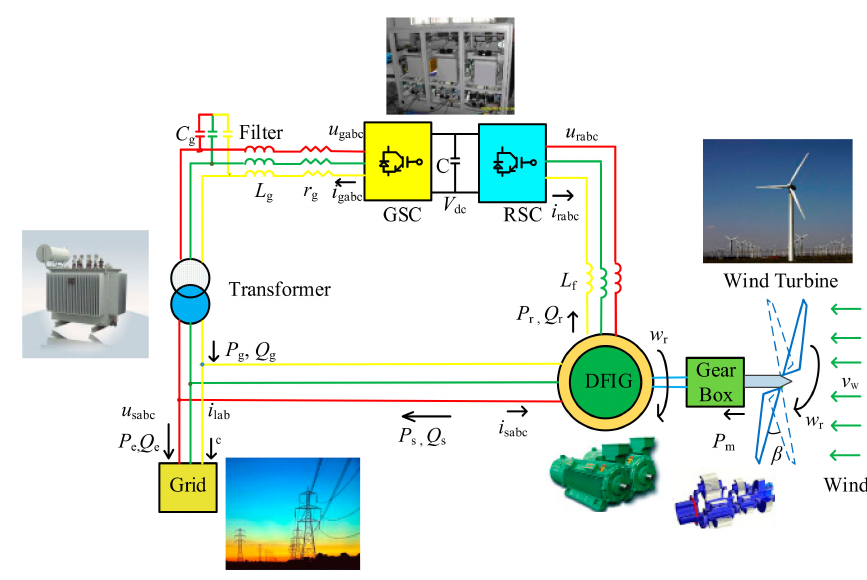
Figure 1. The configuration of a grid-connected DFIG-based wind